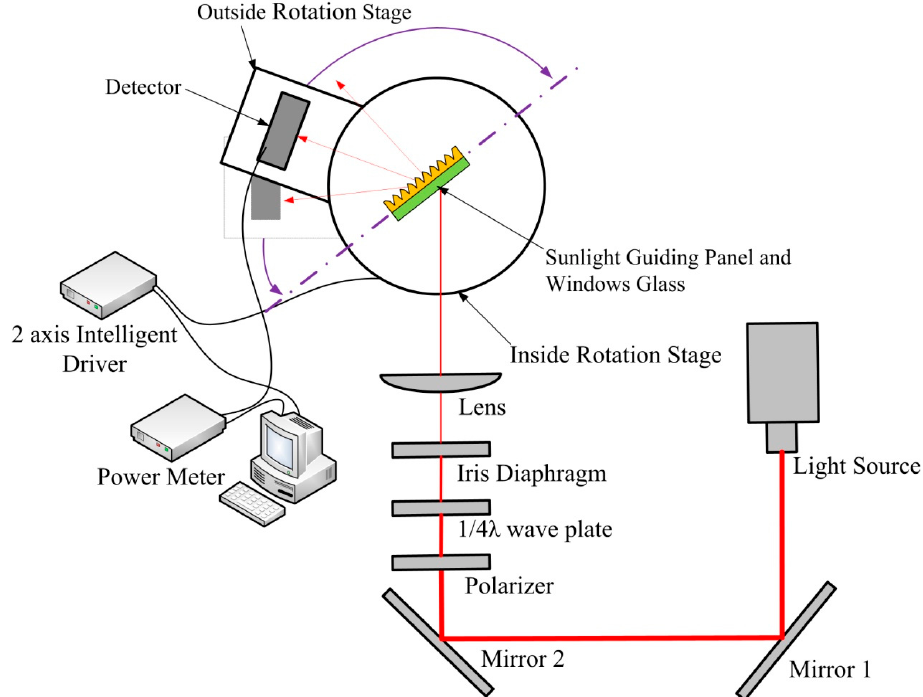
Figure 6. Schematic of the measurement system.